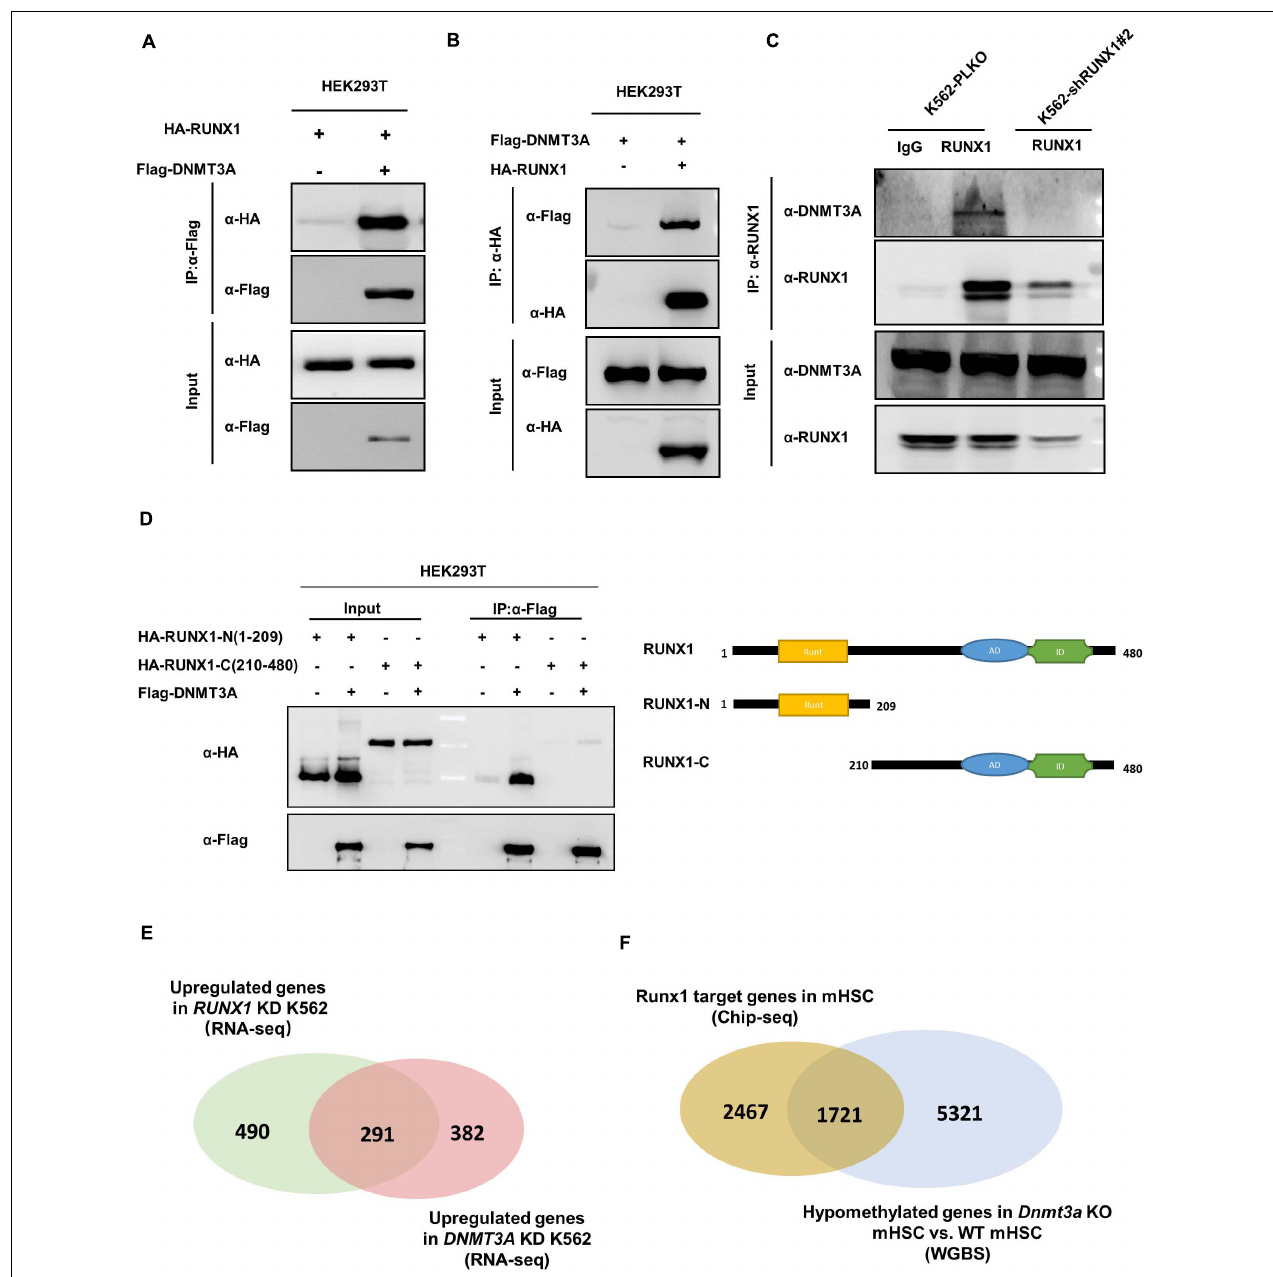
FIGURE 5 | RUNX1 directly interacts with DNMT3A. (A,B) DNMT3A interacts with RUNX1 when exogenously expressed in HEK293T cells. The interaction was detected in either immunoprecipitation of DNMT3A (A) or reciprocal immunoprecipitation of RUNX1 (B) . (C) Endogenous DNMT3A and RUNX1 interact with each other. Endogenous RUNX1 protein in K562 cells was immunoprecipitated and DNMT3A was detected with the specific antibody. (D) DNMT3A interacts with the N-terminal domain of RUNX1. Flag-tagged DNMT3A was co-expressed with RUNX1 full-length or truncations in HEK293T cells. DNMT3A was immunoprecipitated followed by Western blot to detect HA-RUNX1s. (E) Venn diagrams depicting overlap of upregulated genes from RNA-Seq (Fold change > 1.5) in K562 cells with RUNX1 or DNMT3A knocking-down. (F) Venn diagrams depicting overlap between RUNX1 target genes identified by ChIP-seq in mouse hematopoietic stem cells and hypomethylated genes in mHSC with Dnmt3a knocking